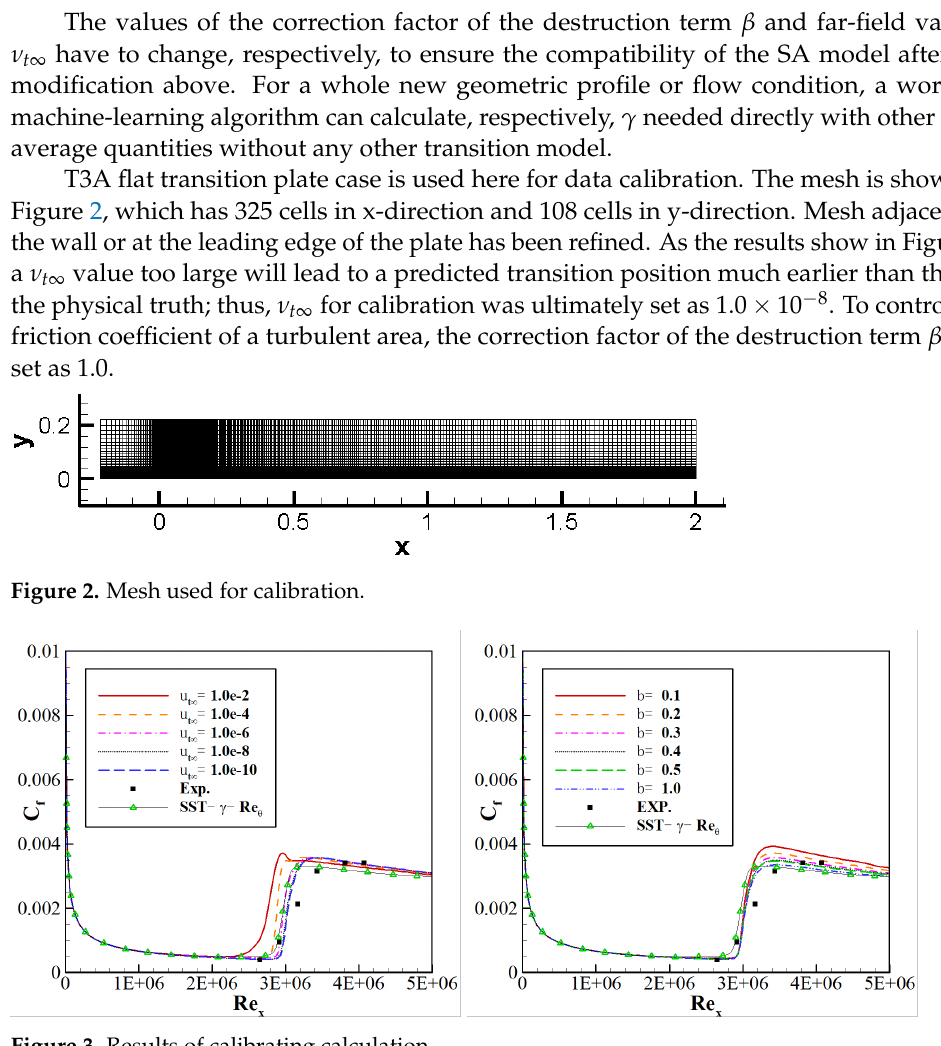
Figure 3. Results of calibrating